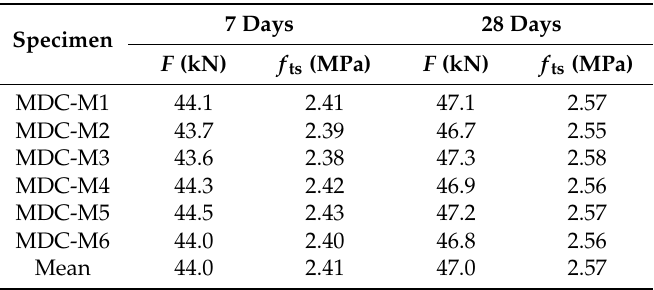
Table 6. Splitting test results of the test specimen series MDC-M (magnetically driven concrete-steel slag with magnetic